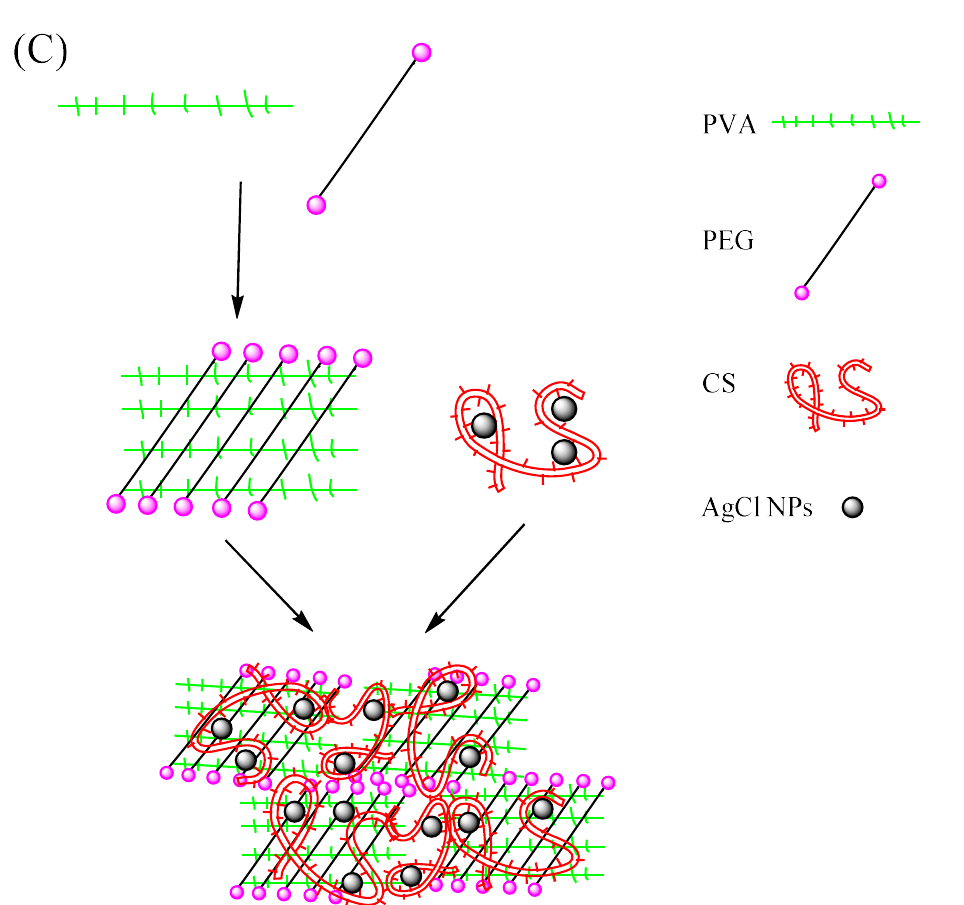
Figure 10. ( A ) Elongation at break and tensile strength of hydrogel, ( B ) schematic diagram of the stretching process of hydrogel AS25, and ( C ) schematic diagram of the formation of a hydrogel containing AgCl NPs having a physically crosslinked network structure.